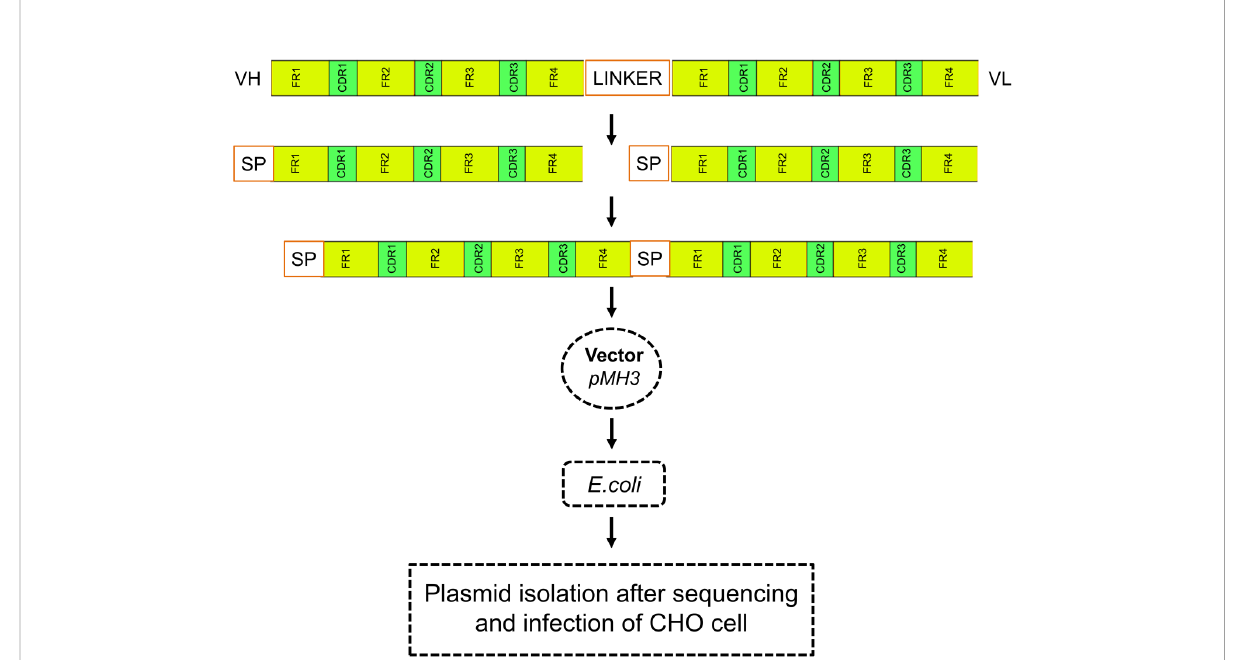
FIGURE 1 Schematic diagram of recombinant construction. Heavy and light chains, as well as their complementary determining regions (CDR), were polymerized and ligated with signal peptides in an scFv-containing linker intermediate. The recombinant construct was cloned into the pMH3 vector and transfected into bacteria. Positive clones were selected, and plasmids containing the necessary immunoglobulin fragments were collected and used for full-length antibody transfection in CHO